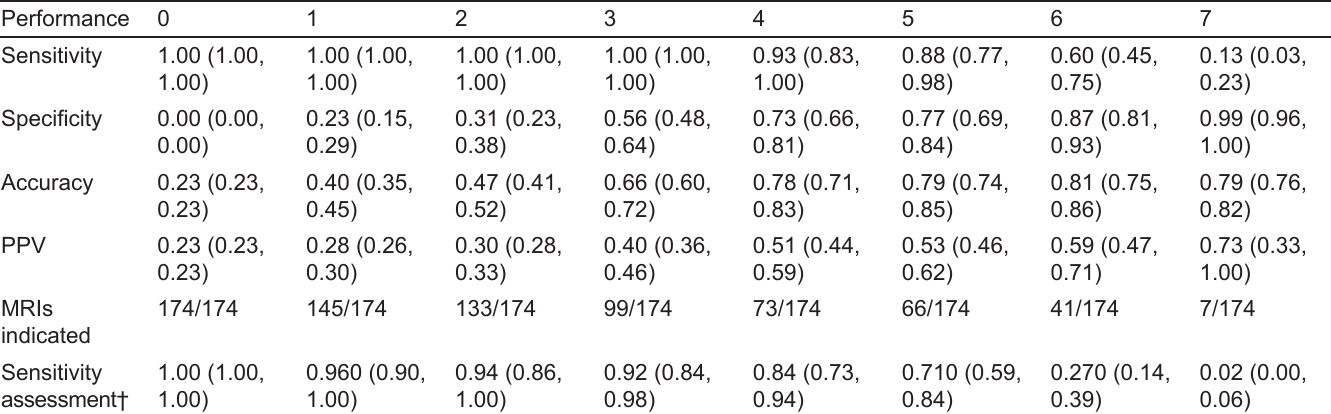
Table 3. Probability of pyogenic spinal infection and number of magnetic resonance images indicated from SIRCH* score cut-off criterion